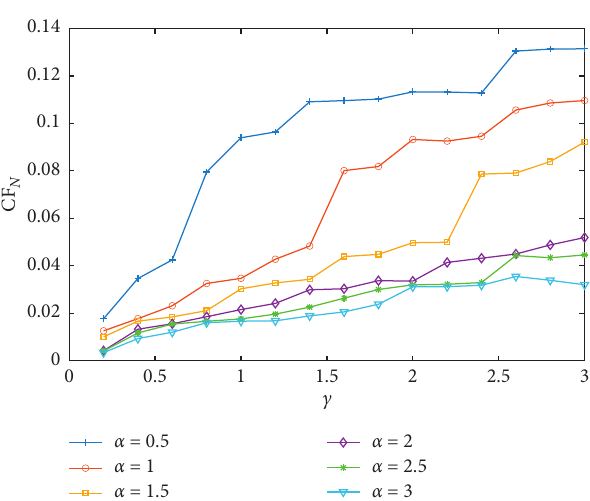
Figure 6: Relationship between CF